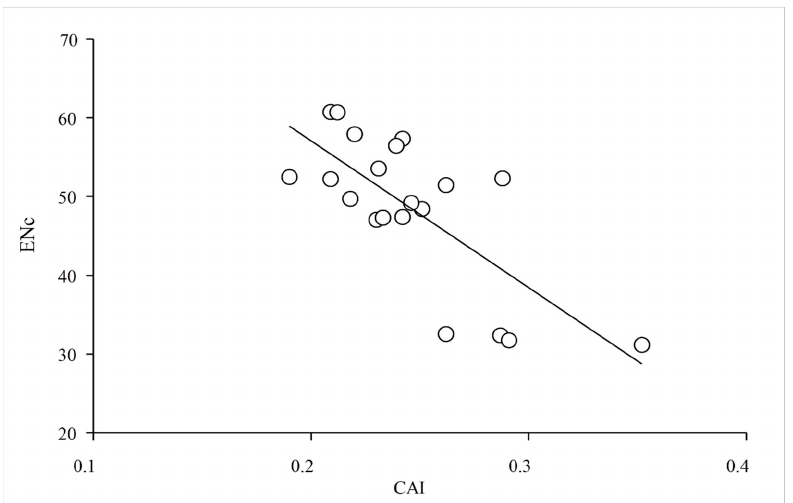
Figure 7. Correlation between codon adaptation index (CAI) and the effective number of codons